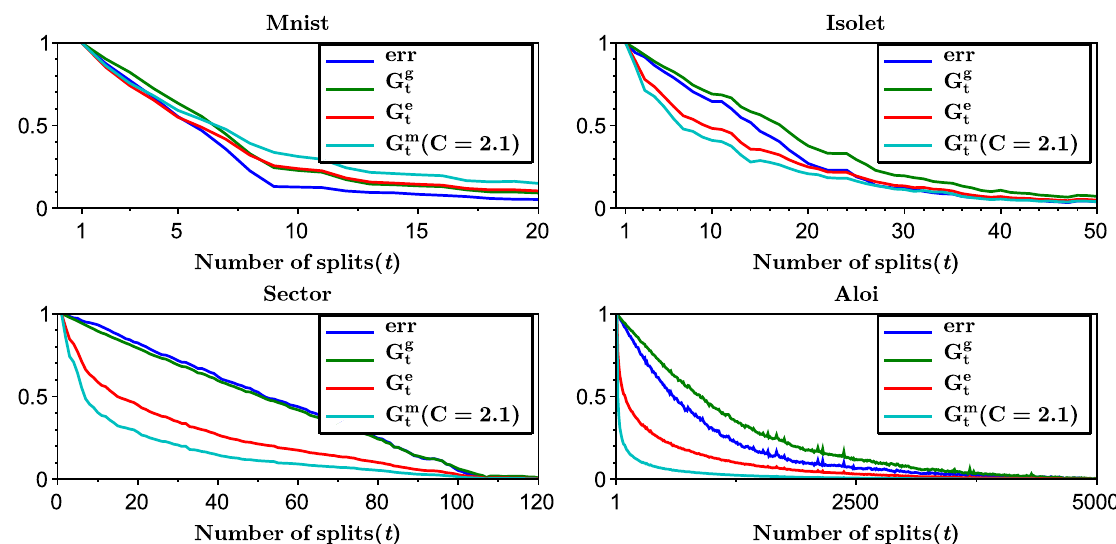
Figure A1. Functions G e number of splits. Figure is recommended to be read in